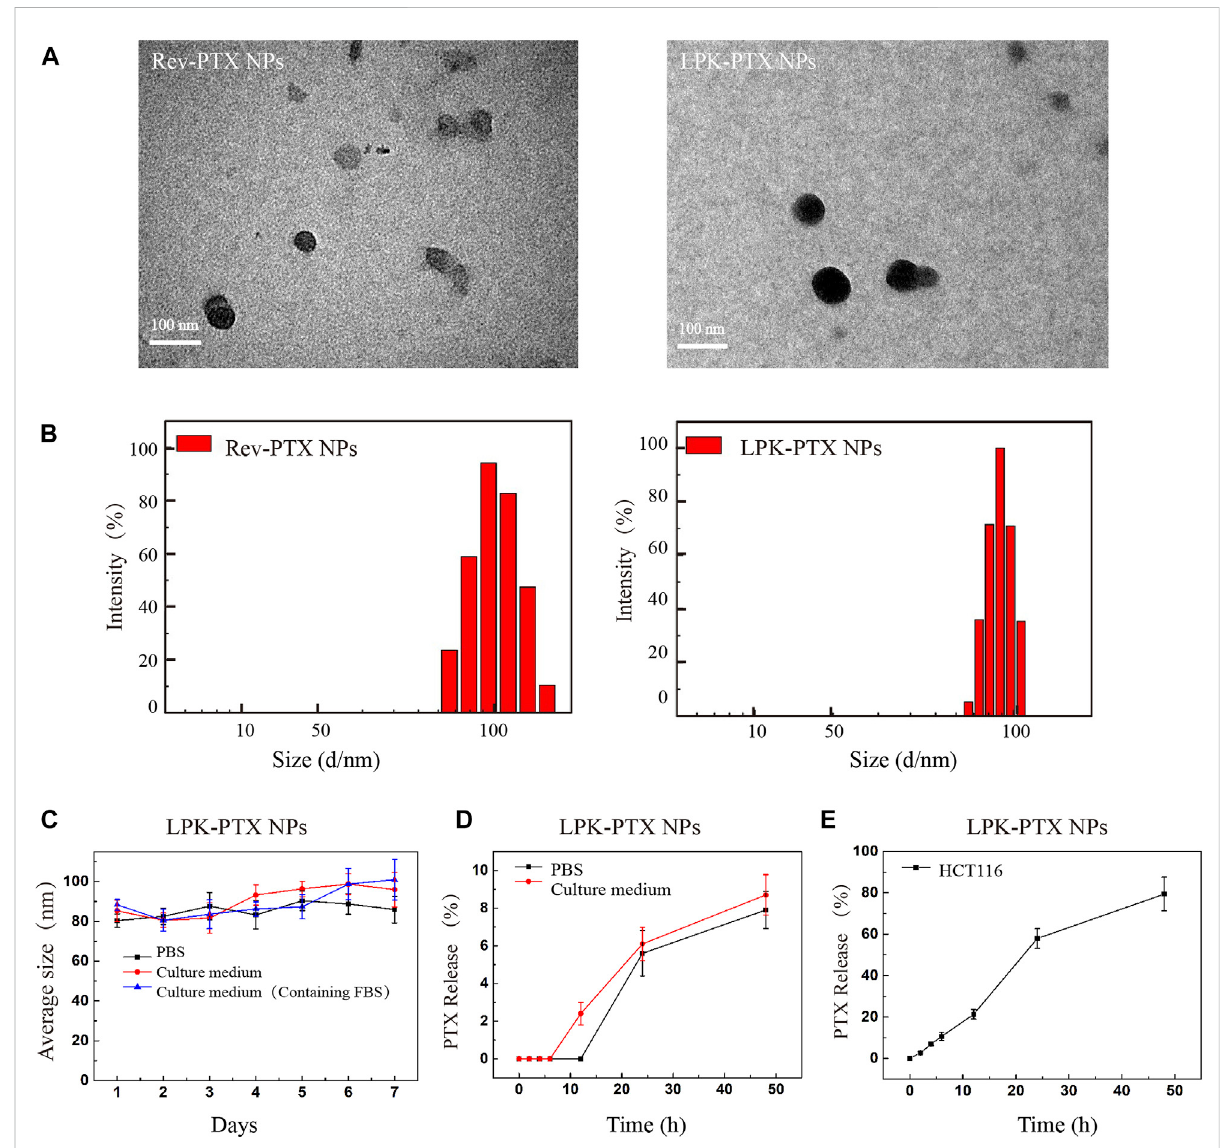
FIGURE 2 Characterizations of LPK-PTX NPs. (A) LPK-PTX NPs morphology were imaged via TEM. Black particles were Rev-PTX NPs or LPK-PTX NPs. (B) DLS studies showed particle size distribution of Rev-PTX NPs and LPK-PTX NPs ( n = 3). (C) Size distribution of LPK-PTX NPs showing their stability in PBS, Culture medium and Culture medium (Containing FBS). The PTX release rate of LPK-PTX NPs in PBS, Culture medium (D) and HCT116 cells (E) were detected at different time points (0, 2, 4, 6, 12, 24, and 48